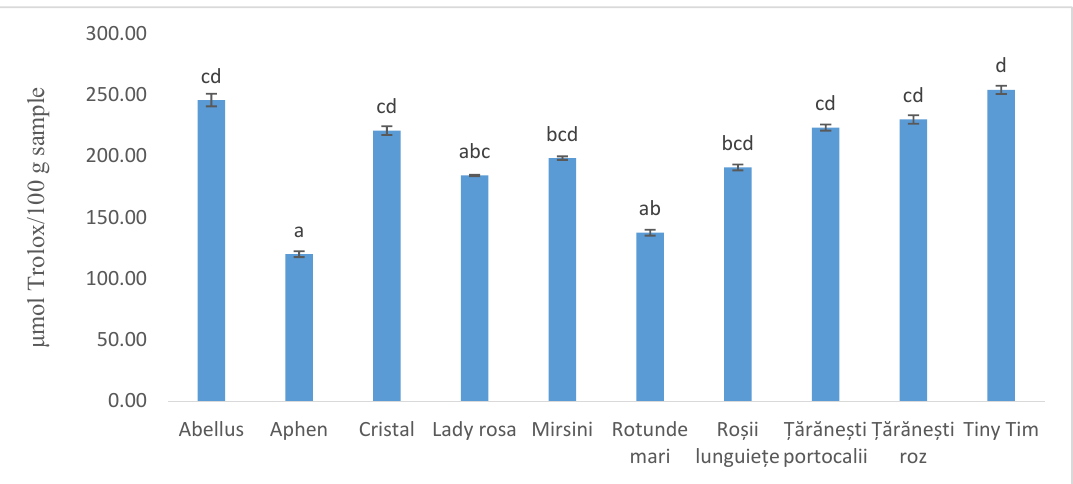
Figure 1. Antioxidant activity of tomato peels extracts by DPPH assay. Different letters indicate significant differences by Tukey’s test, at 5% probability.